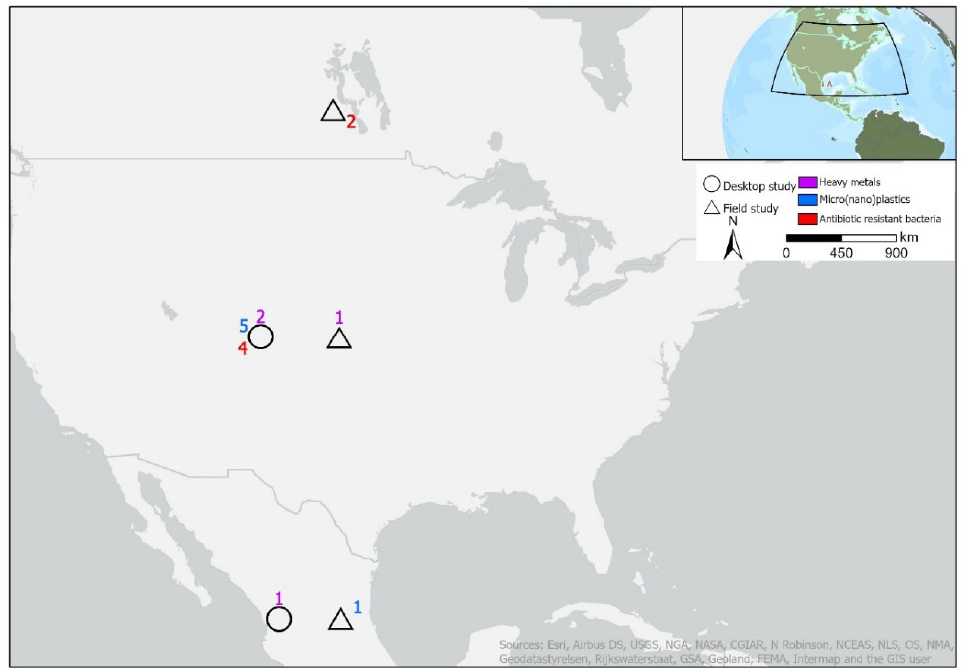
Figure 3. North America: Number of studies on heavy metals, micro(nano)plastics, and antibiotic ‐ resistant bacteria considered in our review, per country. Field studies were counted for the country where the analysis was performed, desk studies were counted for the country of the